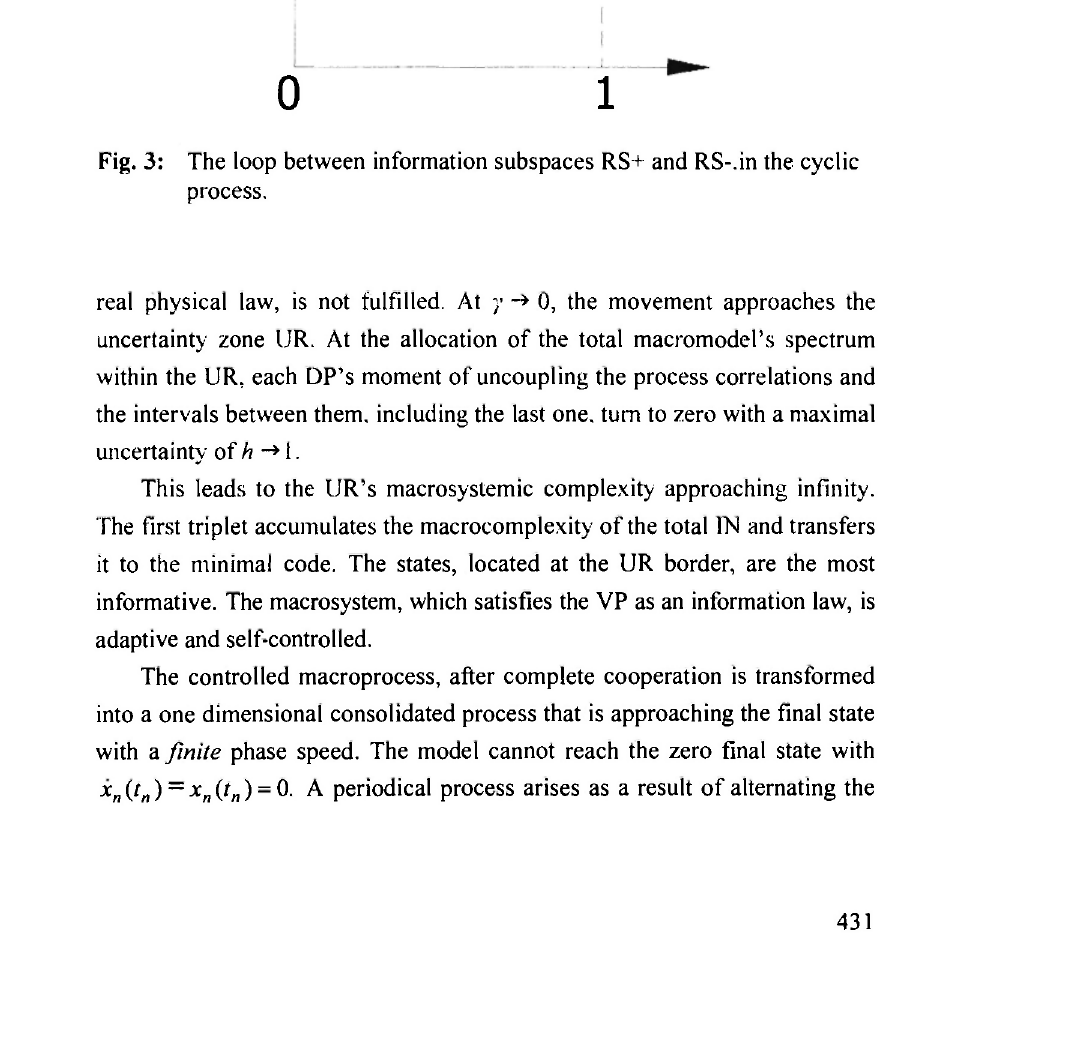
Fig. 3: The loop between information subspaces RS+ and RS-.in the cyclic